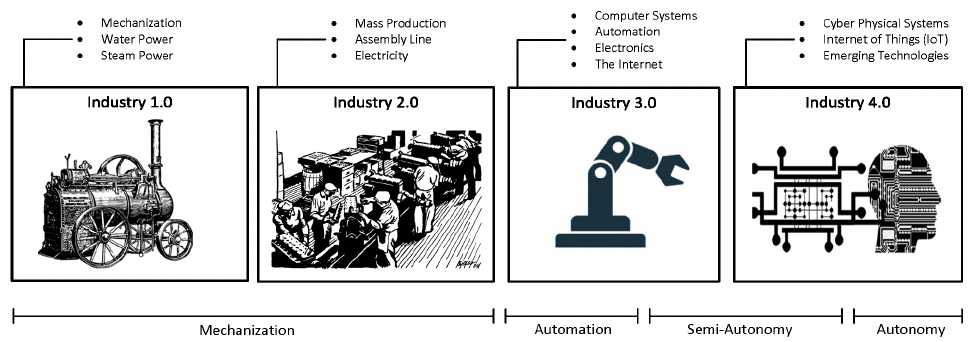
Figure 1. Diagram depicting the four industrial revolutions and degrees of system